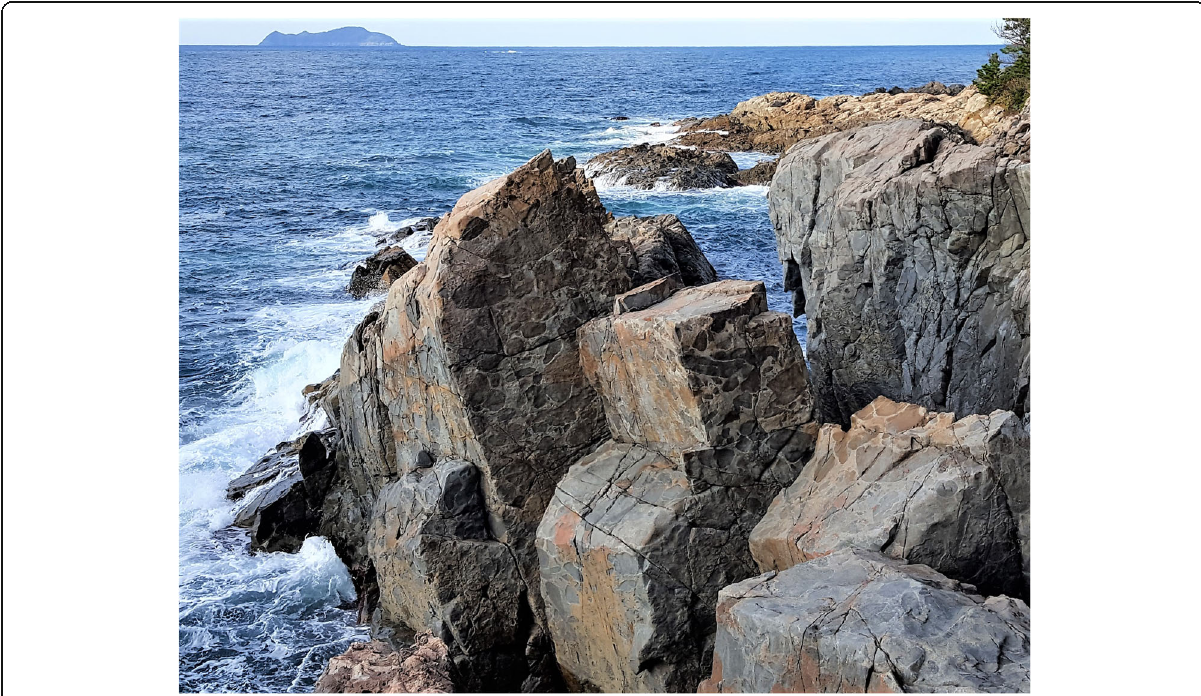
Fig. 5 Granitic intrusion with densely interspersed with sub-spherical mafic domains from a costal section at the San ’ in reagion. The